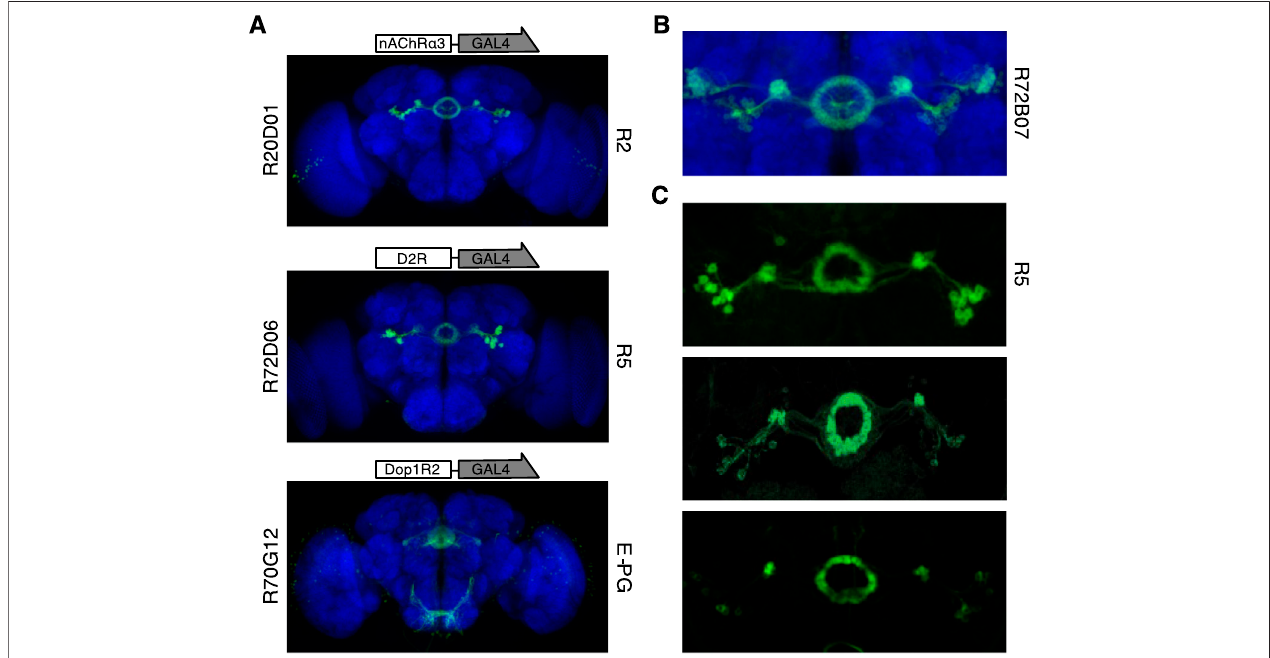
FIGURE 3 | Driver lines selected and neurons targeted. (A) Images of the pattern expressed by the GAL4 lines selected from the Janelia FlyLight Project database (https:// fl web.janelia.org/cgi-bin/ fl ew.cgi) (Jenett et al., 2012). Starting from the top: the R20D01, with the promoter sequence corresponding to the putative enhancer sequence of the nAChR α 3 gene, targets the R2 neurons; in the middle the R72D06, with the promoter sequence of the D2R gene, targets the R5 neurons; and at the bottomtheR70G12,withthepromoterassociatedto Dop1R2 gene,targetstheE-PGneurons. (B) ExpressionpatternofR72B07-GAL4(imagefromhttps:// fl web. janelia.org/cgi-bin/ fl ew.cgi) which has the promoter sequence associated to the Dop1R1 gene. As can clearly be appreciated, its pattern is widely superimposable with that of R20D01, apart from the TuBu neurons. (C) Expression patterns of three different driver lines targeting the same subclass of neurons (i.e., R5). Starting from the top:imageoftheR58H05-GAL4lineexpressingGFP(10xUAS-IVS-mCD8:GFP)whichwasconsideredbyOmotoetal.(2018)totargetthesameneuronsconsideredas R2 byLiu et al. (2016) and recently de fi ned asR5 neurons (image from https:// fl web.janelia.org/cgi-bin/ fl ew.cgi); in themiddle,pattern ofthenv45-LexA:VP16 driver line expressing GFP (LexAop-mCD8:GFP) which was considered to target R3 neurons (image taken with permission from Kottler et al., 2017); at the bottom, image of the R69F08-GAL4 line (used by Liu et al., 2016) expressing GFP (10xUAS-IVS-mCD8:GFP) that was considered to target R2 neurons (image from https:// fl web.janelia.org/ cgi-bin/ fl